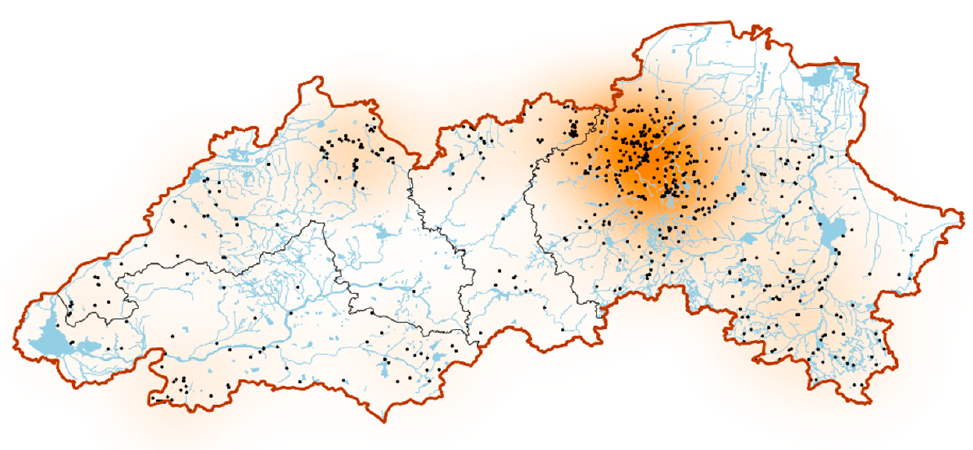
Figure 2. Kernel density of ancient settlements in the Neolithic Luzhong region.